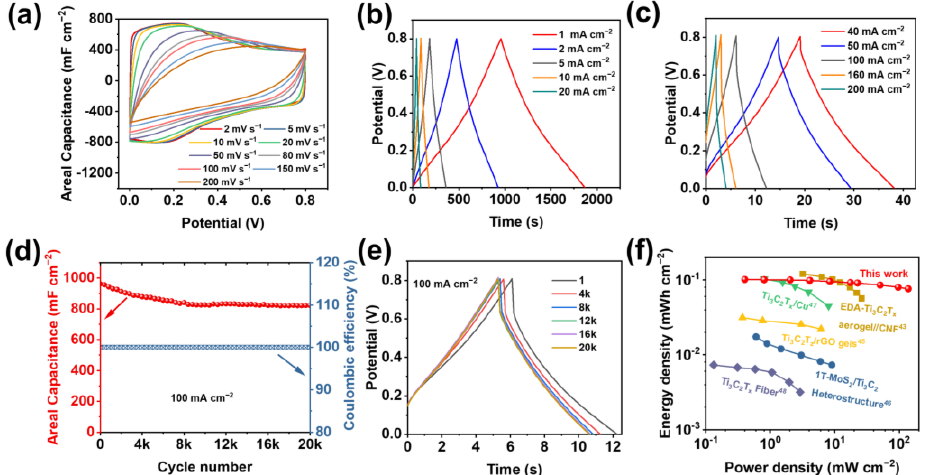
Figure 4. Electrochemical performances of symmetric supercapacitor based on aligned Ti 3 C 2 T x aer- ogel at 10 mg cm −2 . ( a ) CV curves from 2 to 200 mV s −1 ; GCD profiles ( b ) from 1 to 20 mA cm −2 and aerogel at 10 mg cm − 2 . ( a ) CV curves from 2 to 200 mV s − 1 ; GCD profiles ( b ) from 1 to 20 mA cm − 2 ( c ) from 40 to 200 mA cm −2 ; ( d ) Cycling stability and coulombic efficiency with ( e ) typical GCD and ( c ) from 40 to 200 mA cm − 2 ; ( d ) Cycling stability and coulombic efficiency with ( e ) typical GCD profiles at 100 mA cm −2 ; ( f ) Ragone plot. profiles at 100 mA cm − 2 ; ( f ) Ragone